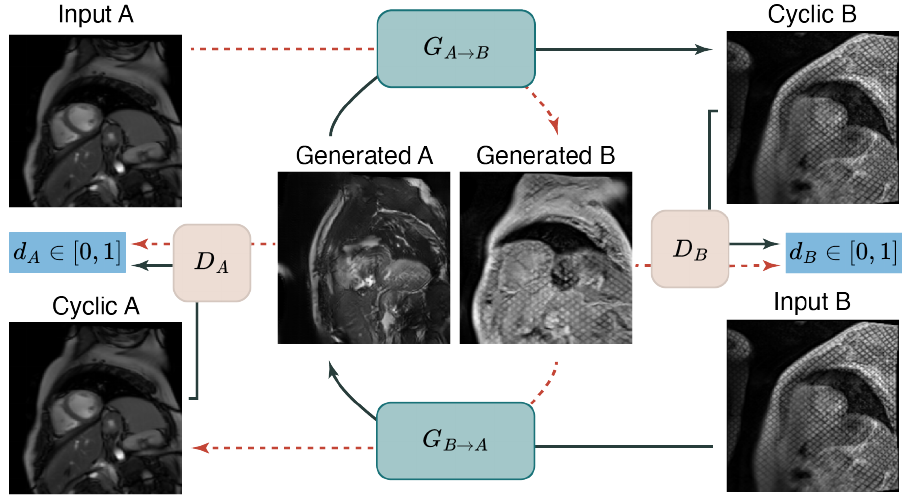
Figure 3. CycleGAN architecture. Training was performed using unlabeled images from groups A and B ( cine and tagged MR images, respectively) for unpaired image-to-image translation. Each discriminator encourages the associated generator to transform images from one domain to outputs that are indistinguishable from the other domain. Additionally, training includes a pixel-wise cycle consistency constraint that minimizes the dissimilarity between arbitrary input images from one domain and its cyclic